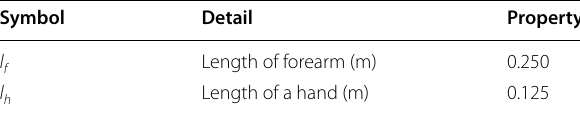
Table 6 Length of parts of the patient body Symbol Detail